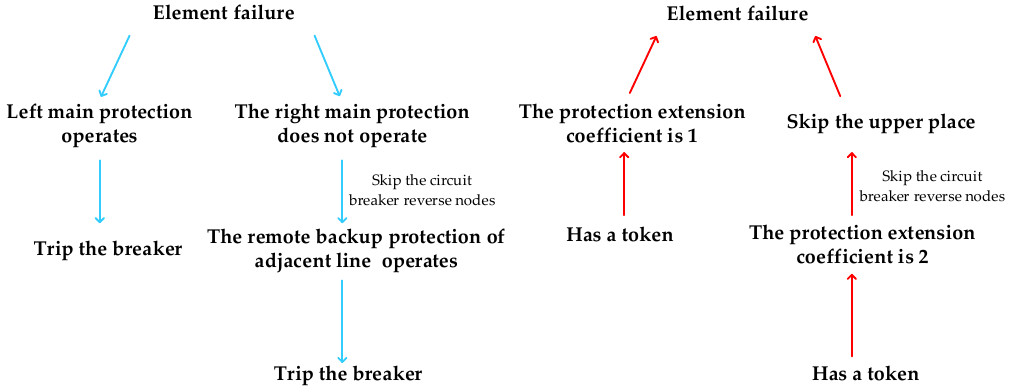
Figure 8. Fault forward processing and backward reasoning.